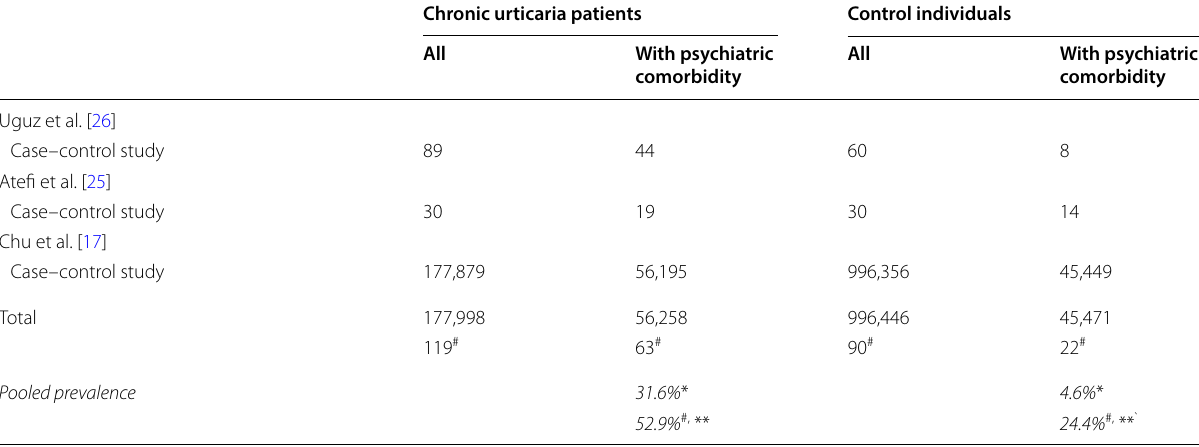
Table 3 Psychiatric comorbidity in chronic urticaria (CU) patients—studies including a control group